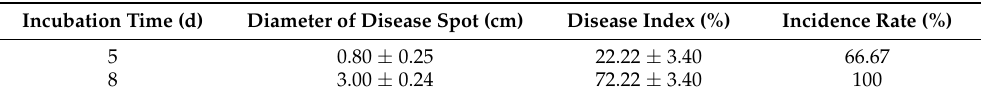
Table 2. The pathogenicity of Bot. dothidea JNHT01 on fresh walnuts at 5- and 8-day in- cubation.